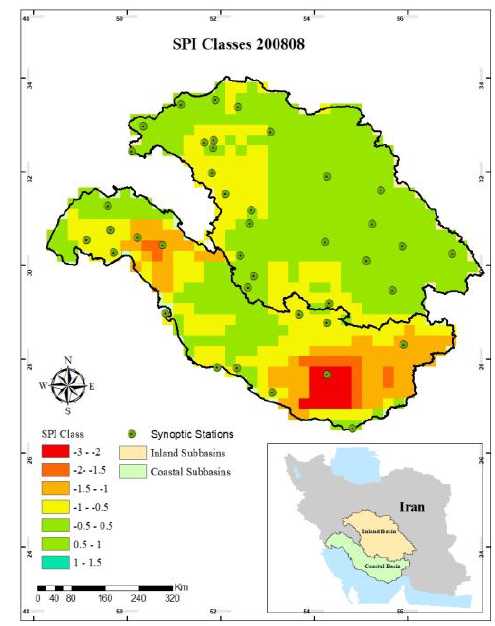
Figure5. SPI Value calculated from TRMM3B43 (200808).